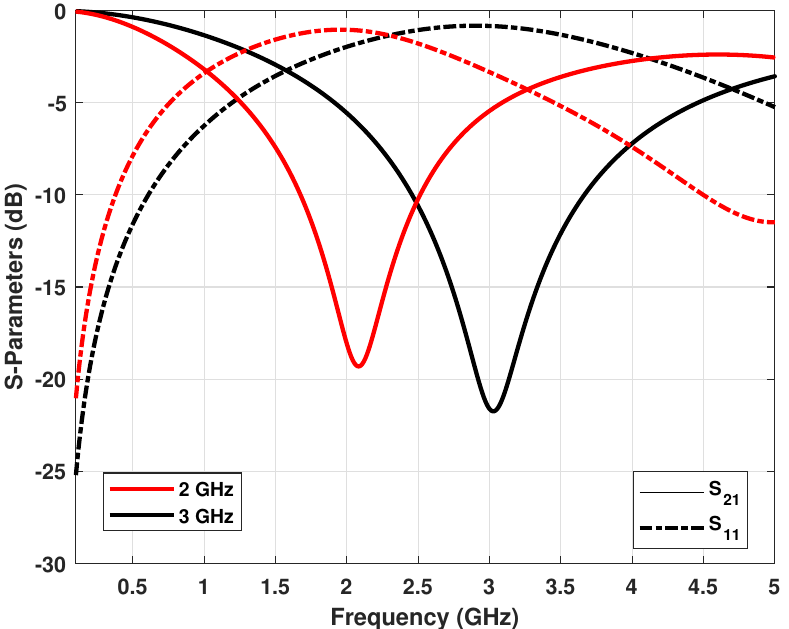
Figure 8. Simulated S–parameters results of the DGS sections for the approximation of the physical dimensions.